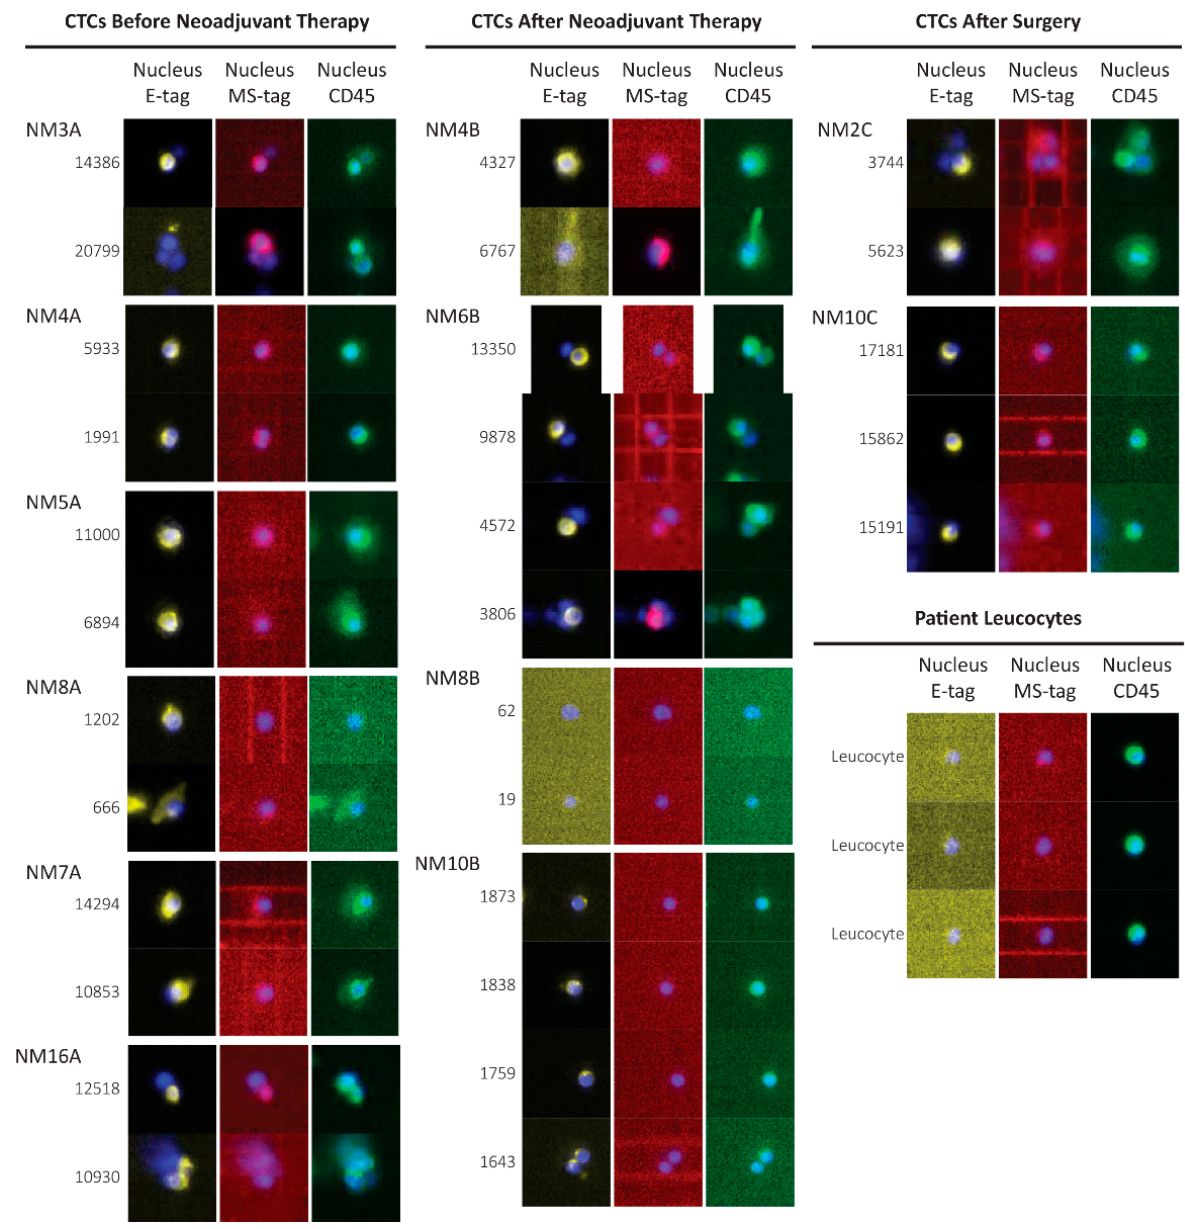
Figure 2. DEPArray panels of representative CTCs identified in non-metastatic esophageal cancer (EC) patients. Images of CTCs obtained before neoadjuvant treatment, after neoadjuvant treatment and after surgery are grouped in separate columns (each including three different imaging channels). A fourth group lists images of patients’ leukocytes. Every line represents an identified cell with its specific ID. Autofluorescence signals on FITC channel (green) of CTCs are well distinct from specific CD45 positivity of leukocytes. We identified frankly epithelial CTCs (yellow pseudocolor) or mesenchymal/stem CTCs (red pseudocolor) or hybrid phenotypes (ID 3806). In patient NM8 ′ s blood drawn after neoadjuvant therapy, we identified cells that were both negative for CD45 and other Grab-all assay tags. We decided to sort these single cells to perform CNA analyses in order to classify them as tumoral or normal cells. The reported numerical codes on the left of each cells represents their DEPArray ID. CTC: circulating tumor cells; CNA: copy number aberration.